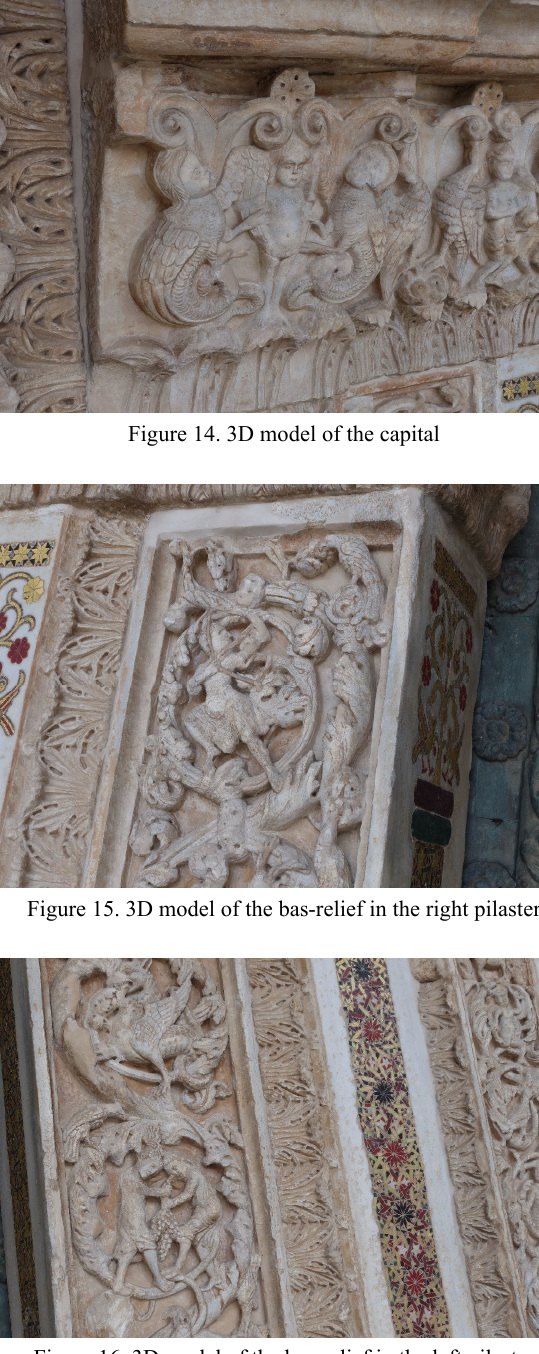
Figure 16. 3D model of the bas-relief in the left